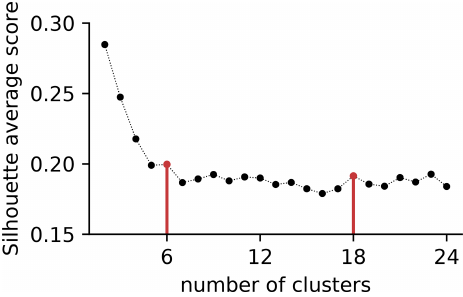
Figure 4. Average silhouette score for the iterative k -means clus- tering algorithm as a function of number of clusters (from k = 2 to 24). Vertical red bars and points show the selected number (6 and 18) of